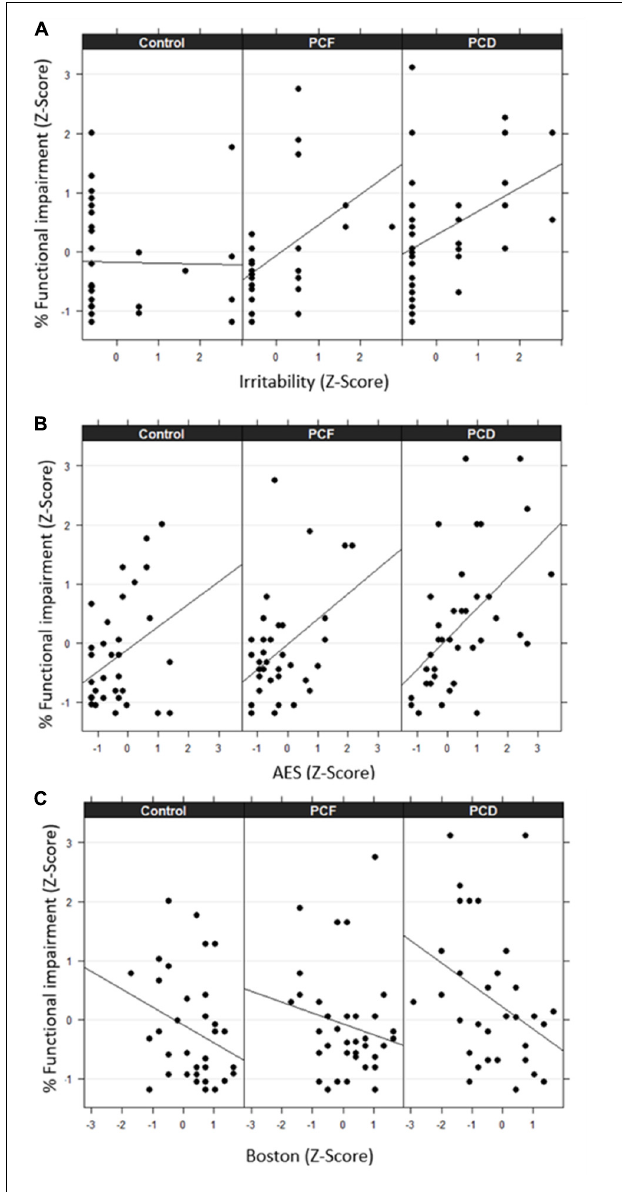
FIGURE 2 | Association between percentage of functional impairment and irritability (A) , apathy (B) , and nomination (C) across the three groups. Values are expressed in terms of z-scores. PCF indicates presbycusis with more preserved cochlear function, while PCD indicates presbycusis with cochlear